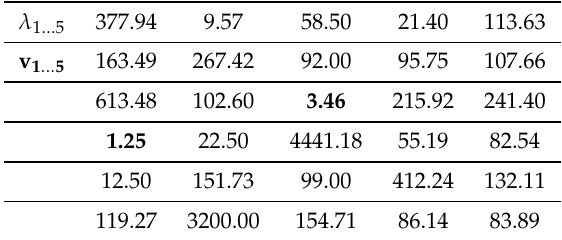
Figure 9. Flowchart of the procedure to determine the entries of the elements in the fault signatures. Table 6. Percent deviation of the fluid leakage fault condition.